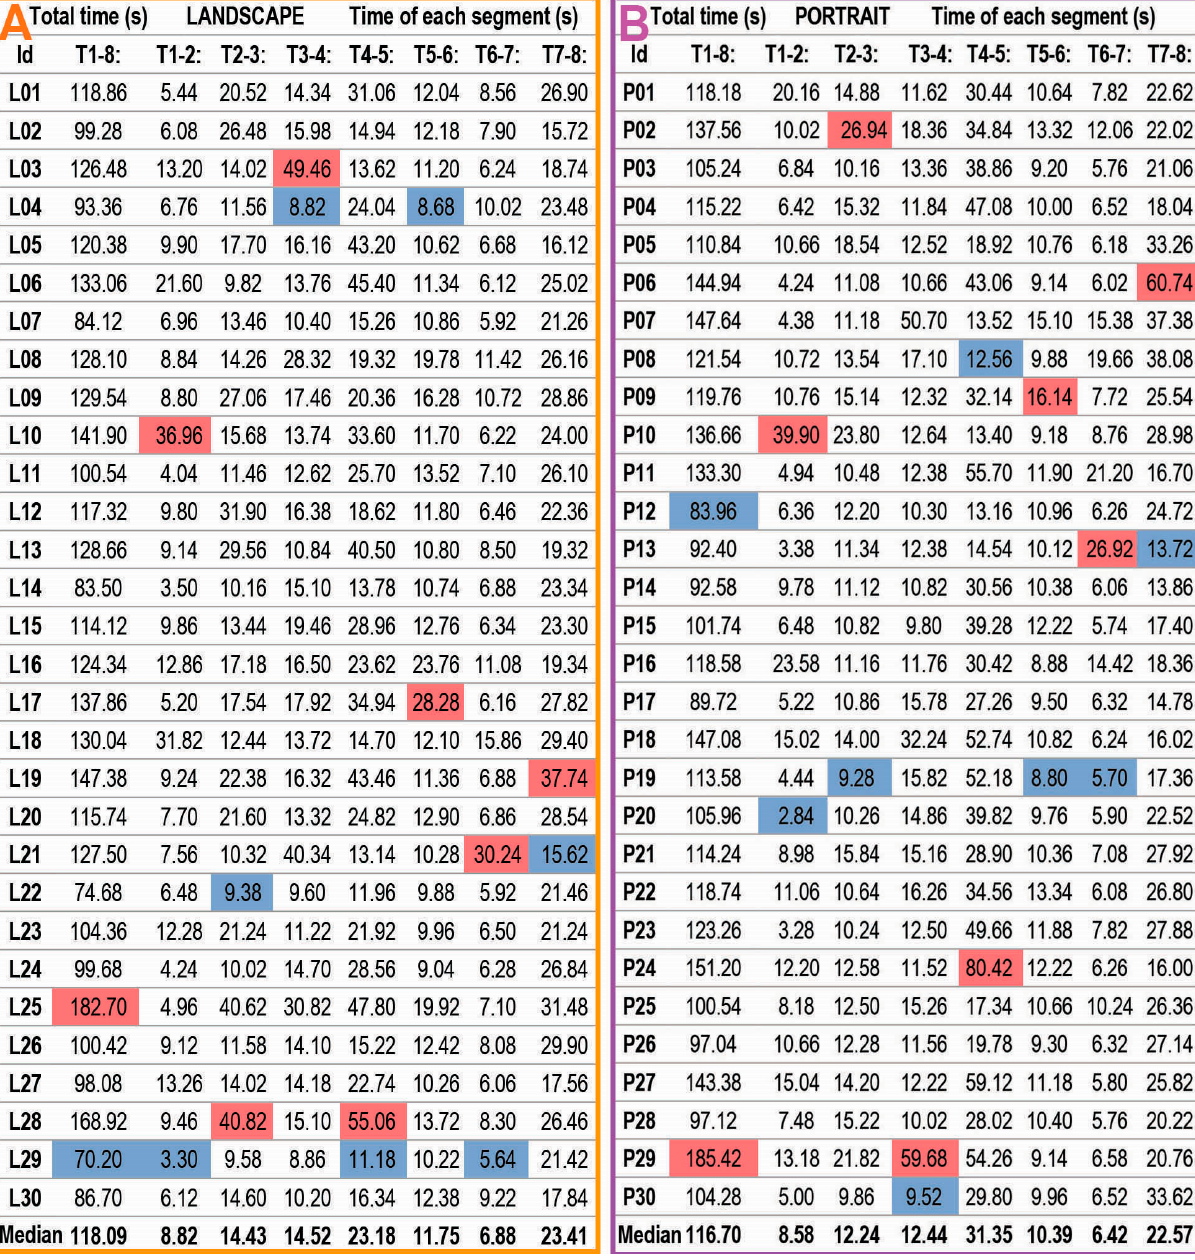
Figure 6. ( A ): Time data of 30 participants with landscape orientation; ( B ): Time data of 30 participants with portrait orientation (red is the longest time, and blue is the shortest time in each column).